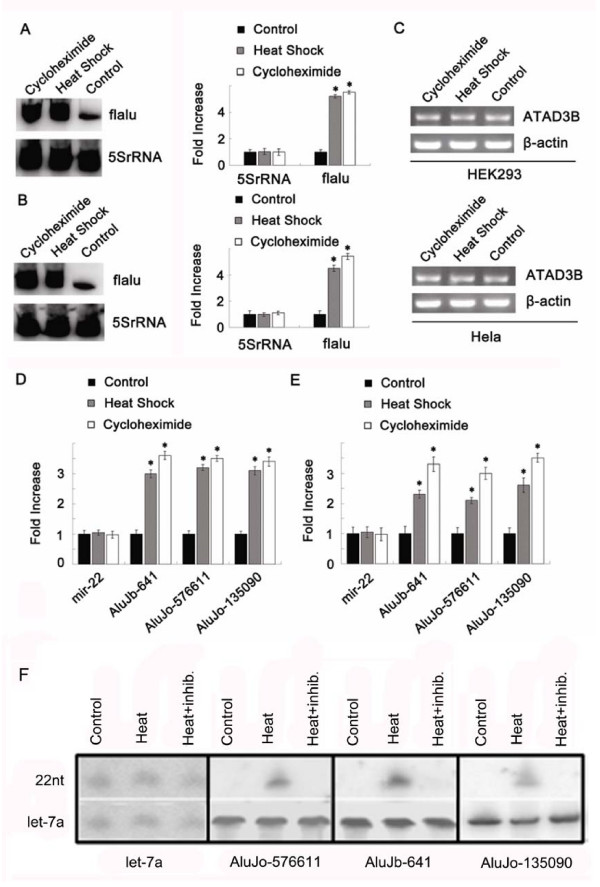
Cycloheximide and heat shock induce a significant increase in the level of co-expression of Alu and its downstream miRNA. A. Northern blotting of full length Alu transcripts after induction by heat shock or cycloheximide. Total RNAs extracted from HEK293 cells were separated by urea PAGE and hybridized with flAlu (full length Alu) or 5S rRNA probes. Northern blotting was performed using the Typhoon 9410 Phosphorlmager. The data are averages of at least three independent determinations. The error bars indicate standard deviations. *P < 0.001; cycloheximide or heat shock compared with the control group. B. Northern blotting was used to detect changes in Alu expression in HeLa cells after cycloheximide or heat shock induction. C. RT-PCR of expression of the host gene ATAD3B in HEK293 and HeLa cells after induction by heat shock and cycloheximide. Beta-actin was taken as a loading control. D. After cycloheximide and heat shock induction, the expression levels of Alu-related miRNAs in H293 cells were examined by real-time PCR. 5sRNA was taken as a loading control. The expression levels of miRNA were normalized to that of 5sRNA and the results in different cases were normalized to the expression levels in the control. The results are representative triplicate experiments and are given as mean and S.D. E. After cycloheximide and heat shock induction, real-time PCR was used to detect changes in Alu-related miRNAs in HeLa cells. F. Northern blotting showing inhibition of Pol-III or Pol-II activity by tagetitoxin. Let-7a was taken as both negative and loading control.